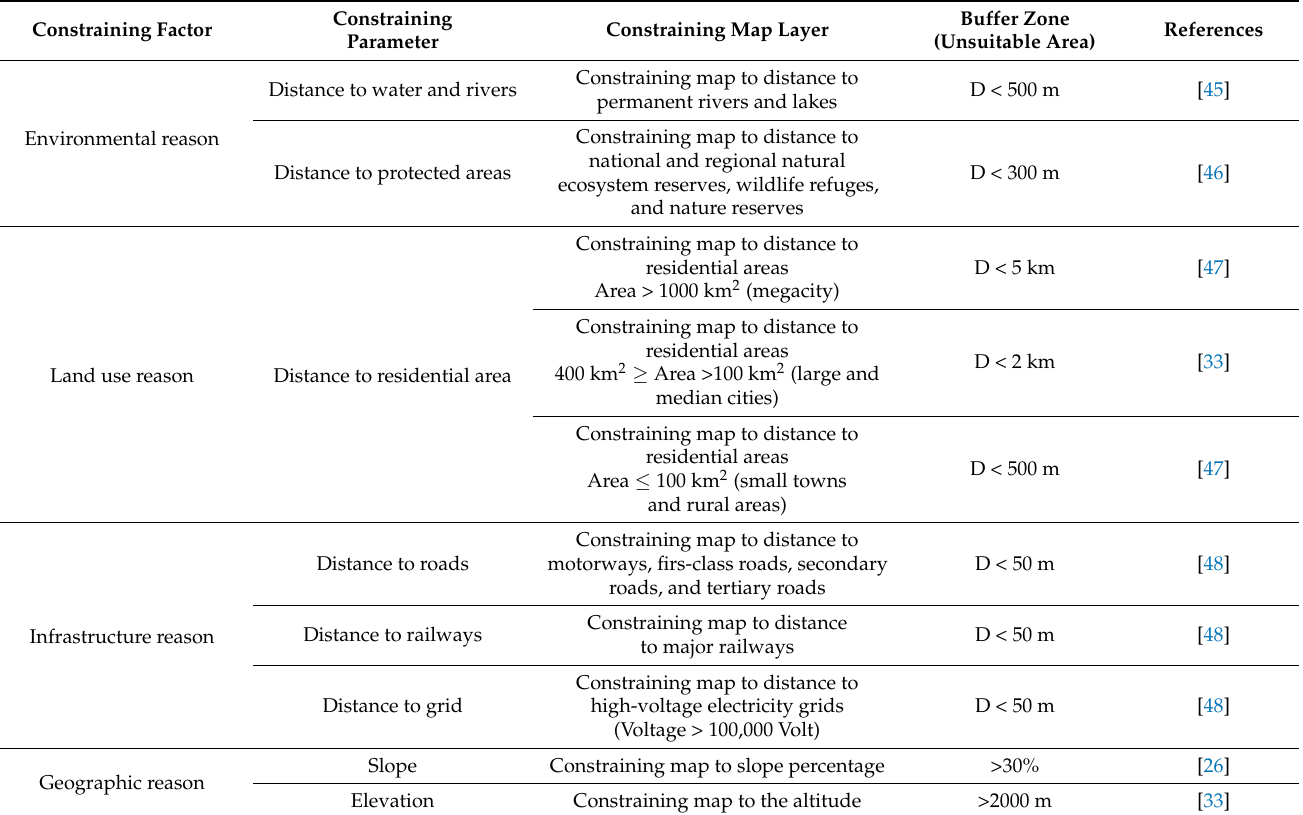
Table 1. Constraining factors of the unsuitable